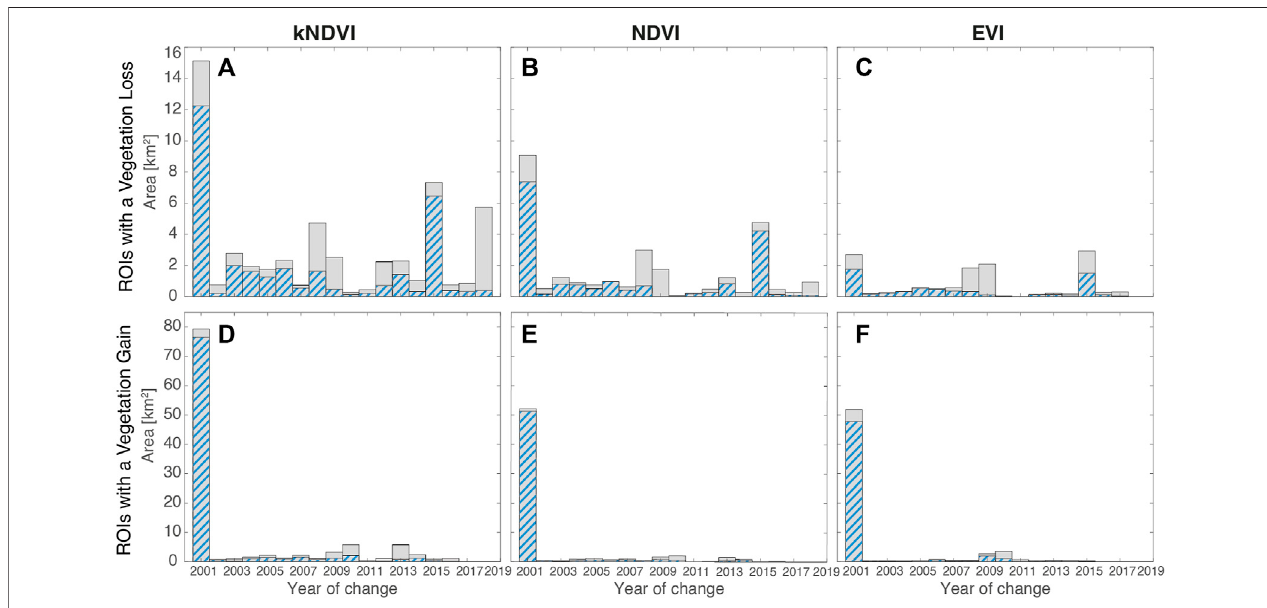
FIGURE 4 | Distribution of the year of change. The blue-dashed portion of the distributions refers to the subset of ROIs wherein an hydrological alteration also occurred. (A) – (C) distributions of the year of change for the ROIs with a vegetation loss detected through kNDVI, NDVI and EVI, respectively. (D) – (F) distributions of the year change for the ROIs with a vegetation gain detected through kNDVI, NDVI and EVI respectively. It is conventionally assumed that all changes caused by a monotonous increase or decrease in the vegetation index occurred in the fi rst year of the analysis (y C = 2001).